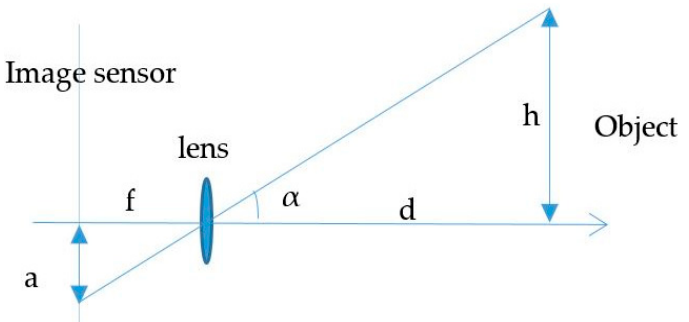
Figure 14. Pinhole camera.